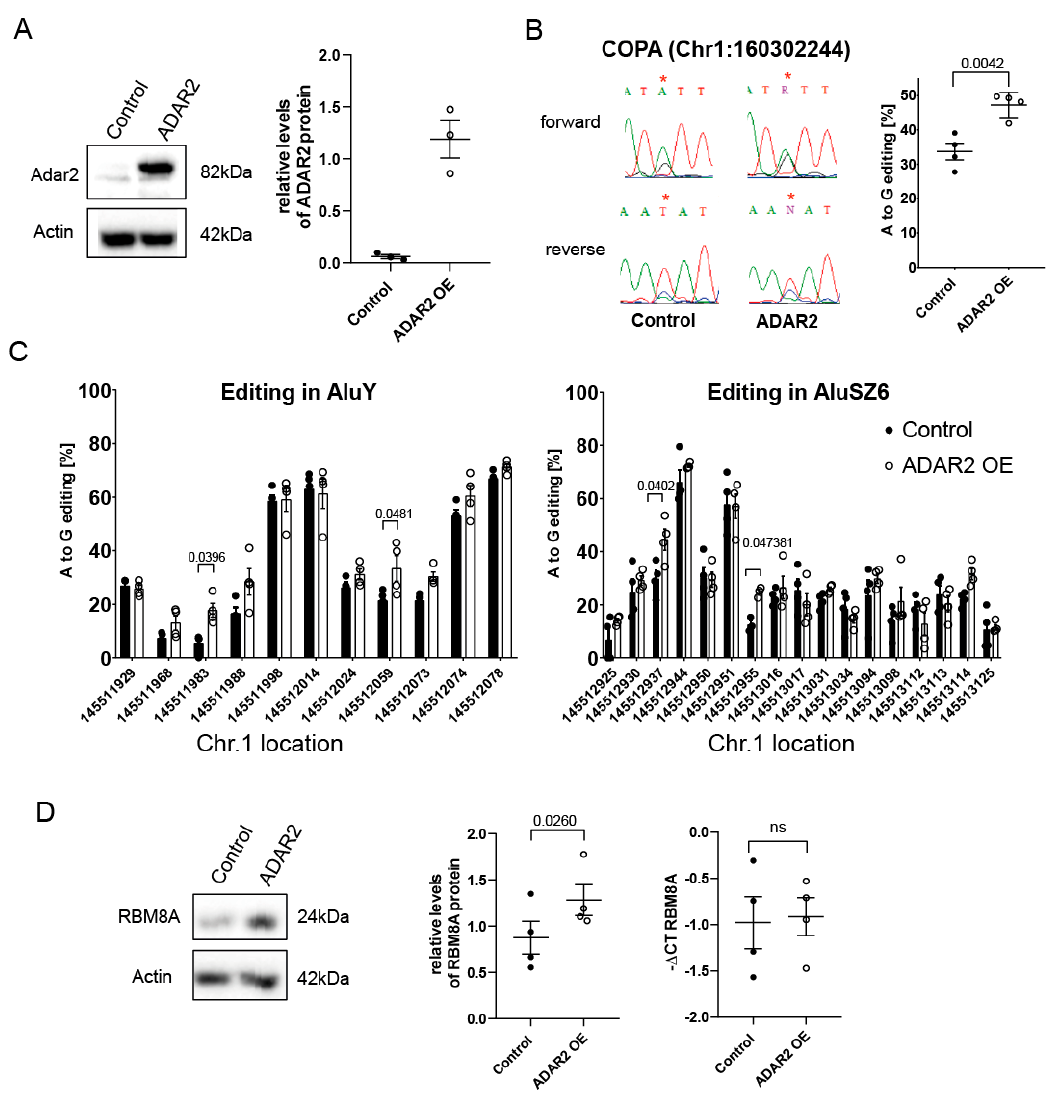
Figure 6. Overexpression of Adar2 in mesothelial cells increases RBM8A 3 ′ UTR editing and RBM8A protein levels. ( A ) Left panel: Western blot analysis of Adar2 expression in mesothelial cells (LP9/TERT1) transfected with empty (control) or Adar2 expression vector. Right panel: quantification of relative Adar2 expression at different passages. Actin was used to normalize. ( B ) Verification of Adar2 activity by determining COPA editing. Paired t -test. ( C ) Comparison of RBM8A 3 ′ UTR editing between empty and Adar2 expression vector-transfected mesothelial cells. Two-way ANOVA multiple comparison. ( D ) Comparison of RBM8A protein and mRNA levels between empty and Adar2 expression vector-transfected mesothelial cells at different passages. Paired t -test.